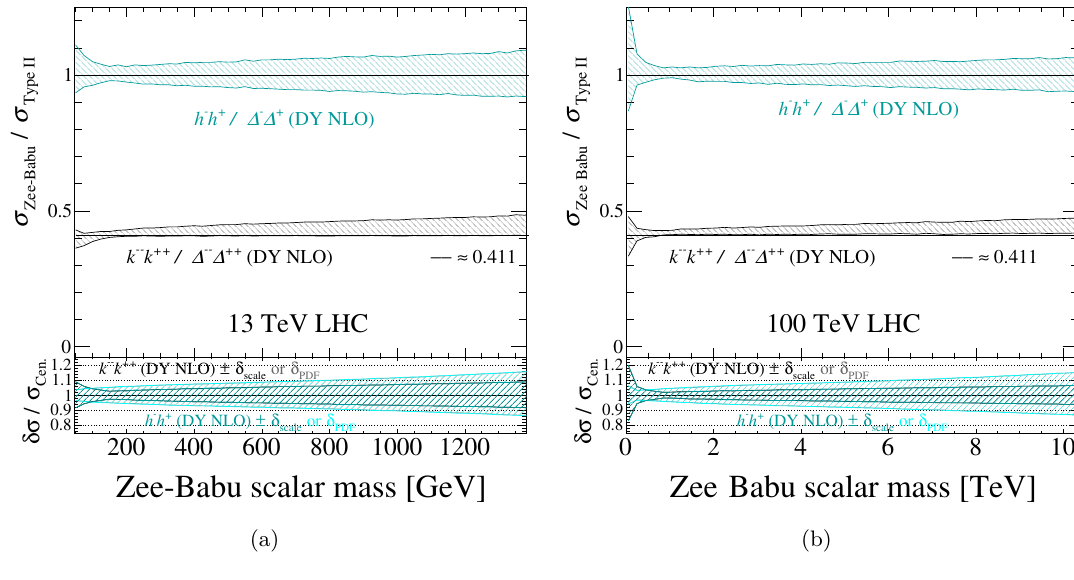
√ Figure 5 . Upper panel: at (a) s = 13 TeV and (b) 100 TeV, and as a function of scalar mass, the ratio of hadronic production cross sections, σ DY (NLO) ( pp → SS † X ) /σ DY (NLO) ( pp → SS † X ) , at Zee − Babu Type II NLO in QCD and with scale uncertainties (band) for S ∈ { k −− , h − } in the Zee-Babu model and S ∈ { ∆ ++ , ∆ + } in the Type II Seesaw model. Lower panel: scale (darker band) and PDF (lighter band)